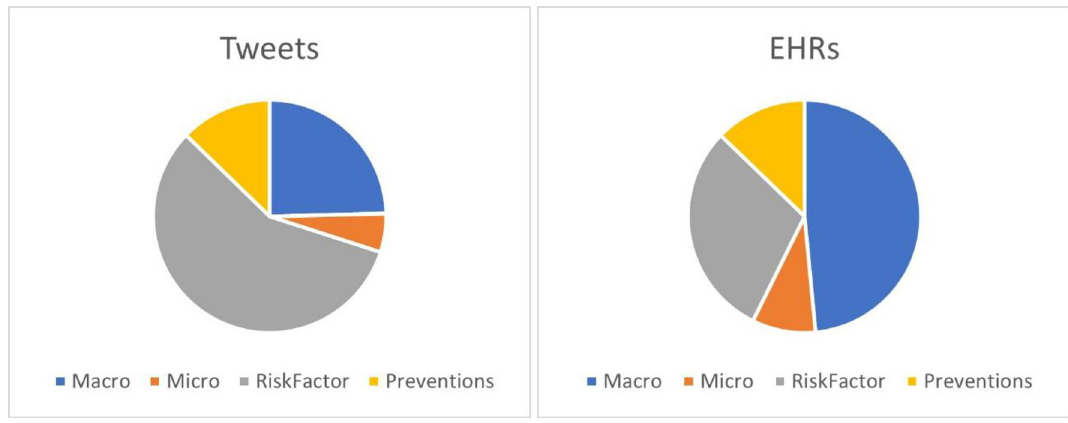
Fig 1. Distribution of the entity types in the PrevComp